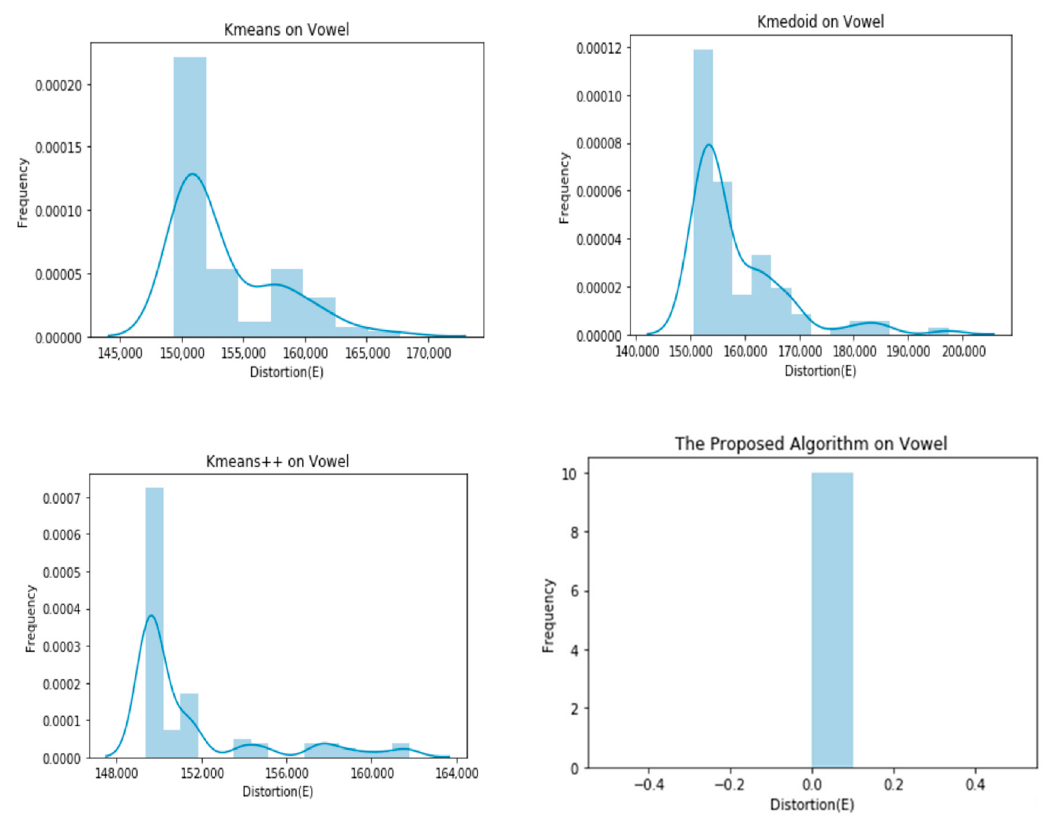
Figure9. Graphicalrepresentation ofEobtainedby100 runs ofdi ff Figure 9. Graphical representation of E obtained by 100 runs of different algorithms on the Vowel dataset.